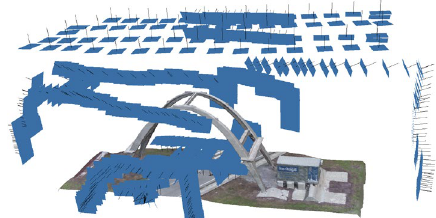
Figure 5 . Parabolic arch of Morano sul Po: oriented images (visible dataset).